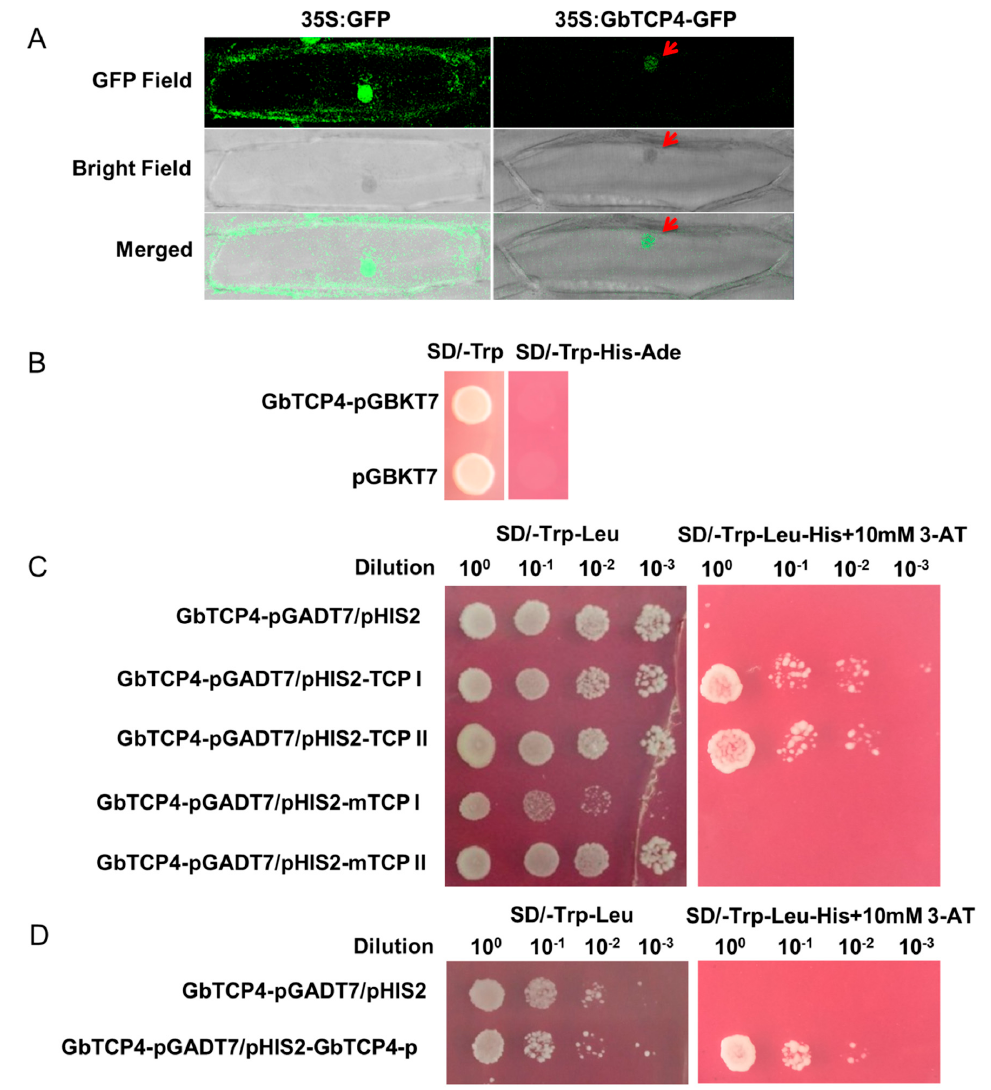
Figure 2. Molecular characterization of the GbTCP4 transcription factor. ( A ) Subcellular localization analysis of the GbTCP4 transcription factor. 35S:GFP is an empty vector control. The red arrow indicates the nucleus. ( B ) Analysis of the transcriptional activation activity of GbTCP4. pGBKT7 is an empty vector control. ( C ) Analyses of the binding of GbTCP4 to TCP I (TGGGTCCCACAT), TCP II (TTGTGGGCCCCT), mTCP I (TAGATTCTAAAG), and mTCP II (TCGGGAGACTCG). ( D ) Analyses of the binding of GbTCP4 to the TCP-binding element in its